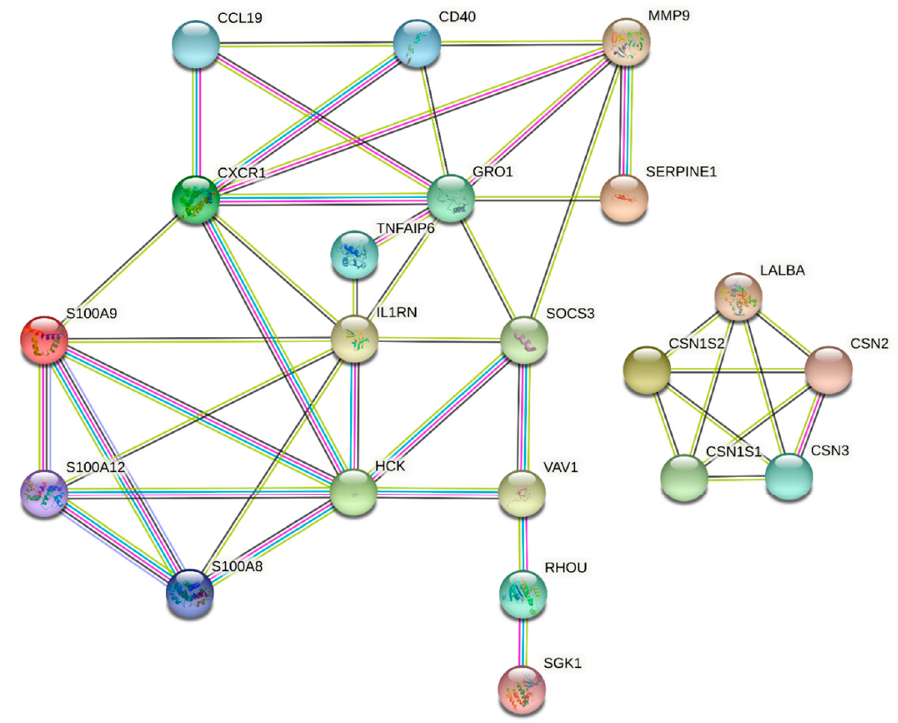
Figure 4. Protein–protein interaction (PPI) network analysis of common differentially expressed genes associated with mastitis in dairy cattle.